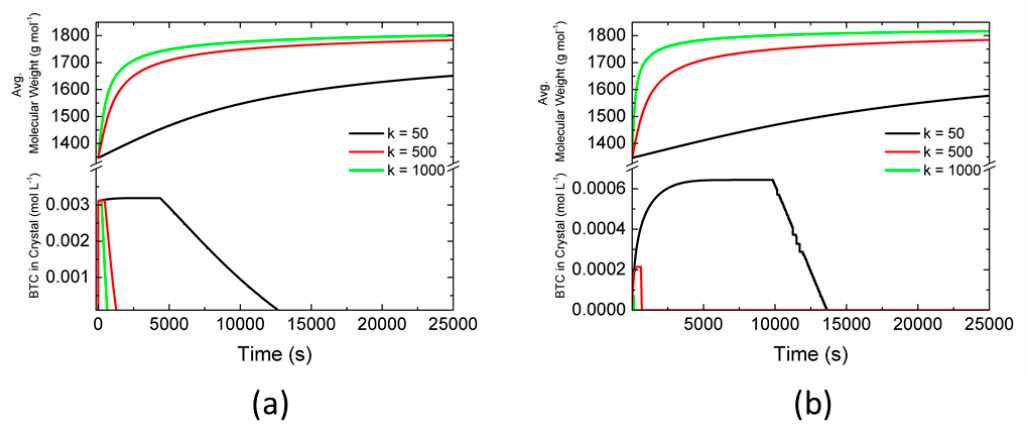
Figure 3. Effect of concurrent crystallization of benzene ‐ 1,3,5 ‐ tricarboxylic acid (BTC) on the formation of SBU oligomers as a function of time for initial supersaturation ratios of ( a ) 1.2 and ( b ) 1.5. The lower portion in both figures shows the concentration of BTC in the crystal phase. The upper portion shows the average molecular weight of SBU oligomers.